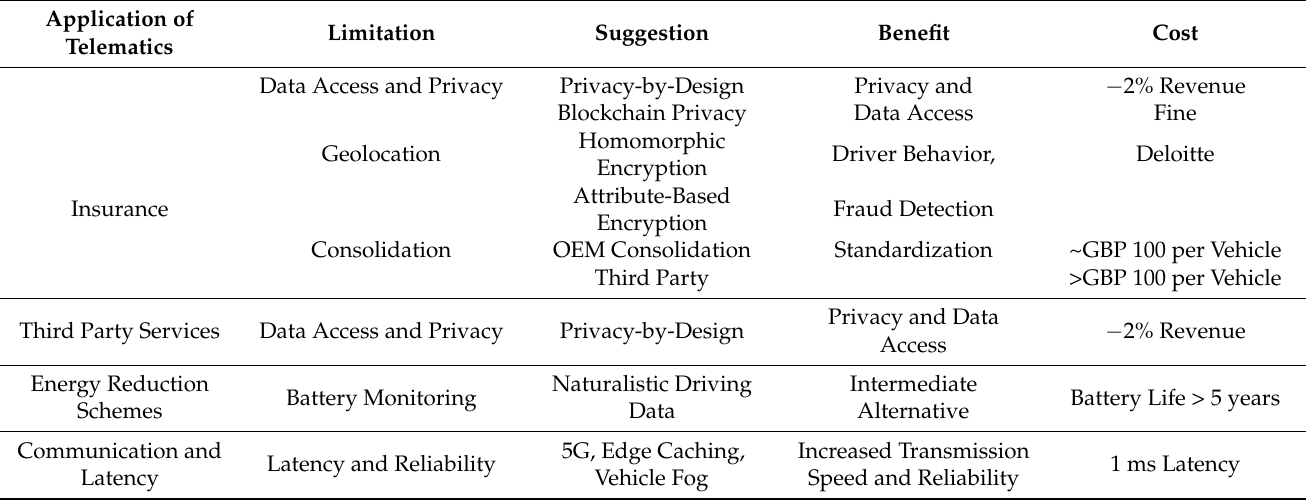
Table 2. Summary of Suggestions and